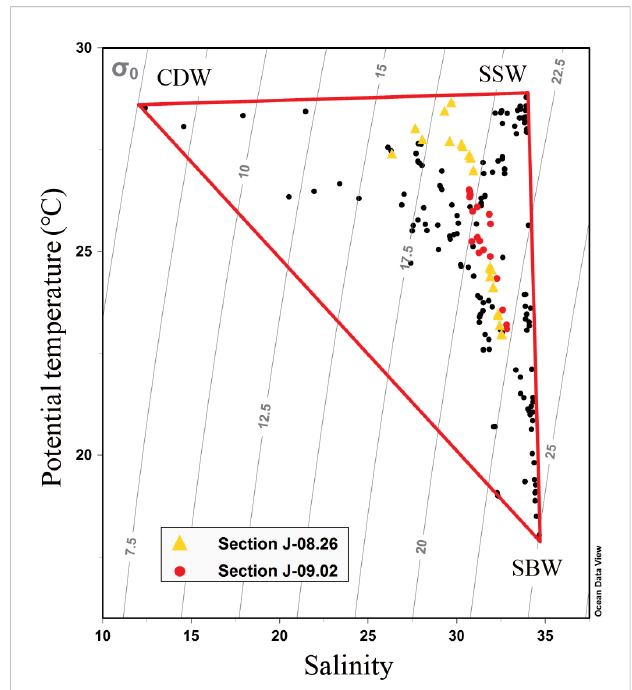
FIGURE 2 Scatter plot of potential temperature ( q ) vs. salinity (S) of all samples during the cruises. The yellow triangles are the samples on August 26, and the red dots are the samples on September 2. The labeled vertices represent the three end-member water masses: Changjiang diluted water, shelf surface water, and shelf bottom